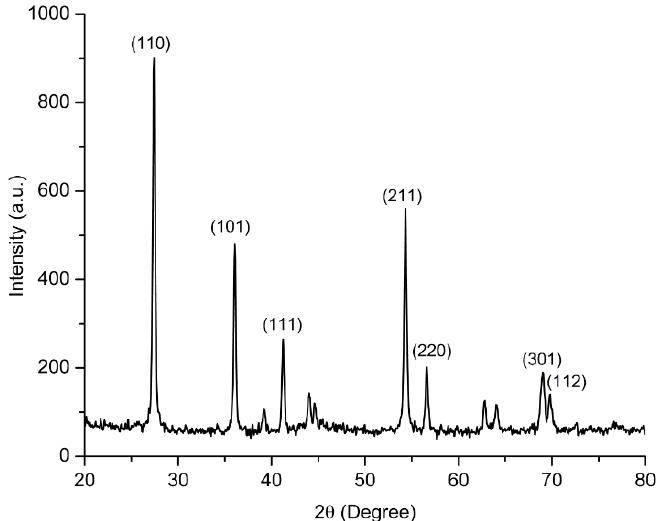
Appl. Sci. 2020 , 10 , x FOR PEER REVIEW Figure 4. X-ray diffraction pattern of rutile TiO 2 . Figure 4. X-ray di ff raction pattern of rutile TiO 2 .